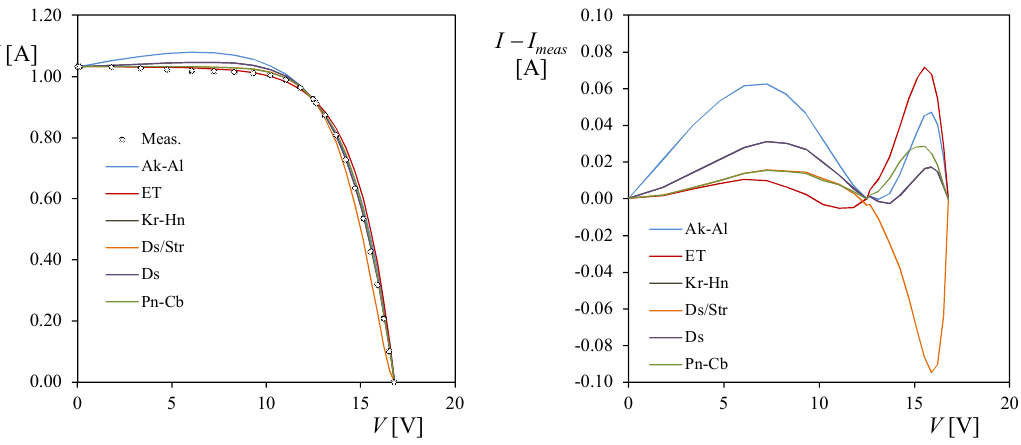
Figure 8. Curves for the explicit models analyzed, fitted to the Photowatt PWP 201 solar panel data using the analytical methods proposed; see Section 2 ( left ). The error in relation to the data is also included in the figure ( right ). Energies 2018 , 11 , x FOR PEER REVIEW